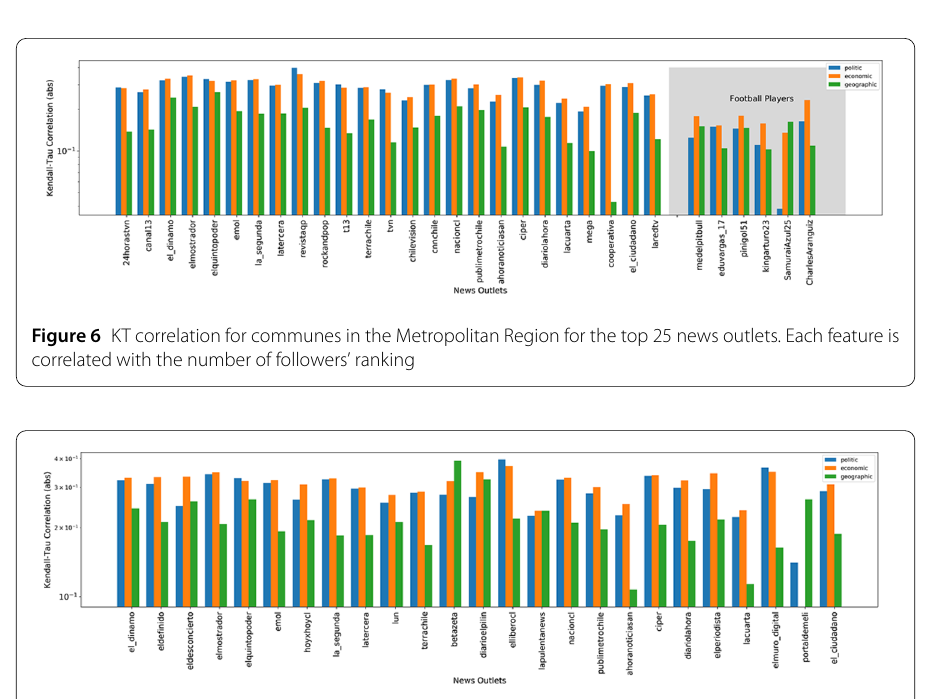
Figure 7 KT correlation for communes in the Metropolitan Region for top 25 newspapers . Each feature is correlated with the number of followers